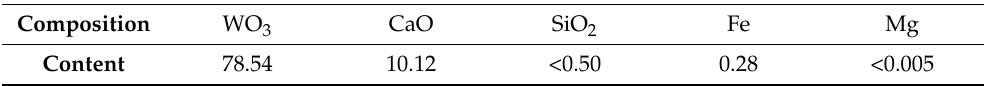
Table 1. Chemical analysis of the pure scheelite sample. (% composition).